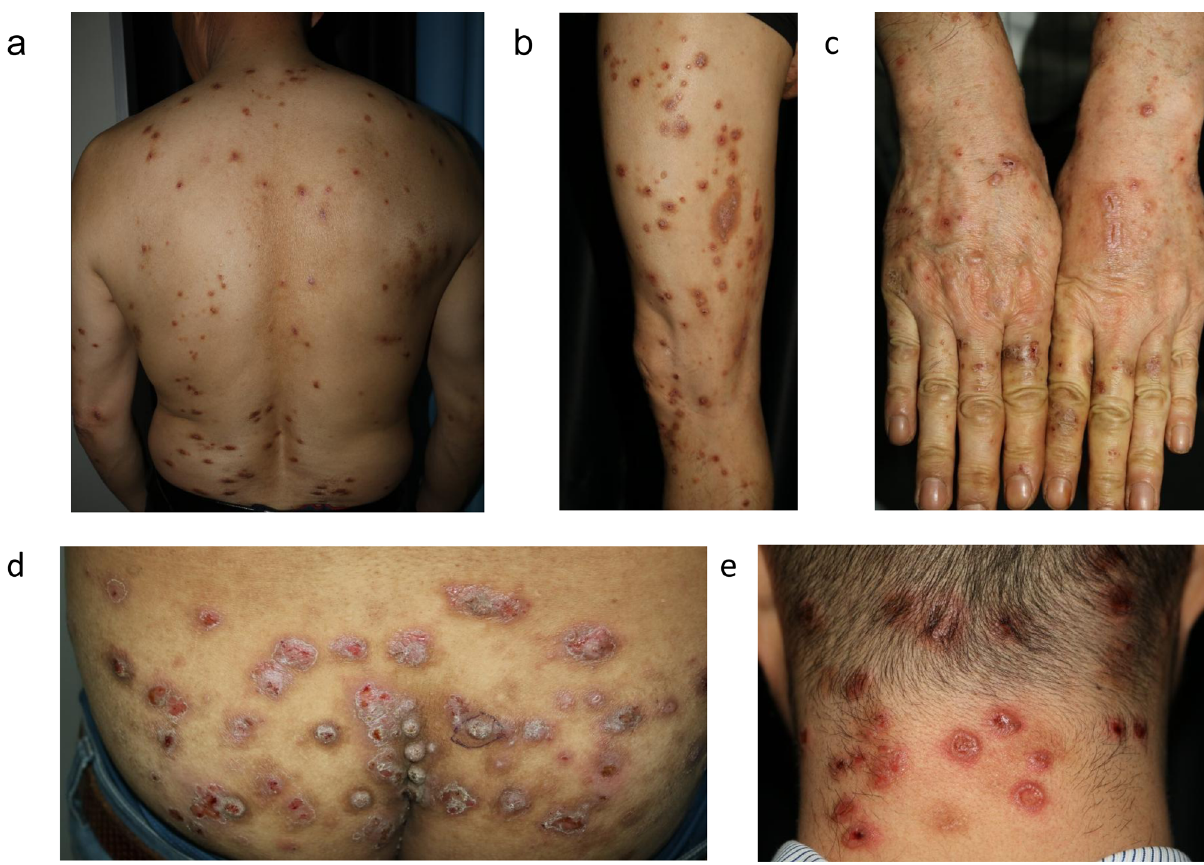
Figure 1: Clinicopathological features of prurigo nodularis. ( a – e ) Multiple excoriated papules or nodules involving typical distribution of trunk with the “ butter fl y sign ” ( no lesion on the center of the back ) , extensors of the extremities, palms, buttocks, and neck. These images were taken from fi ve di ff erent patients with PN: ( a ) P36, ( b ) P23, ( c ) P26, ( d ) P18, and ( e )